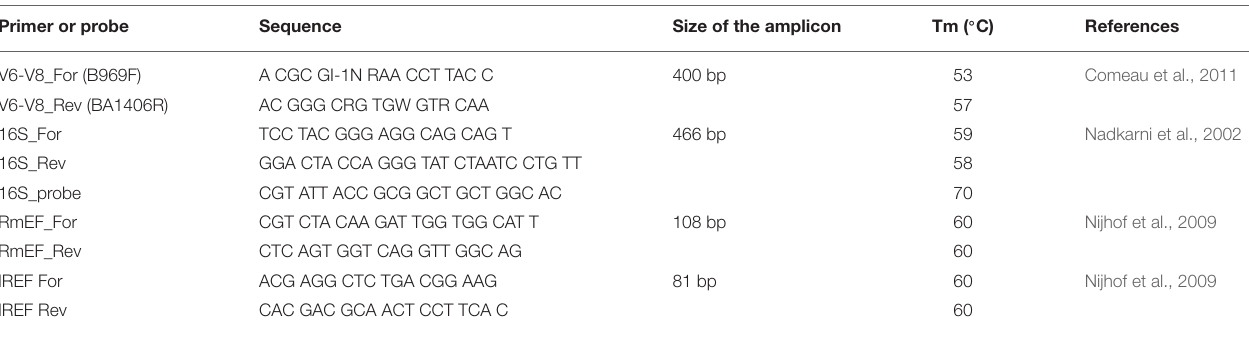
TABLE 1 | List of primers and probe used in this study. Primer or